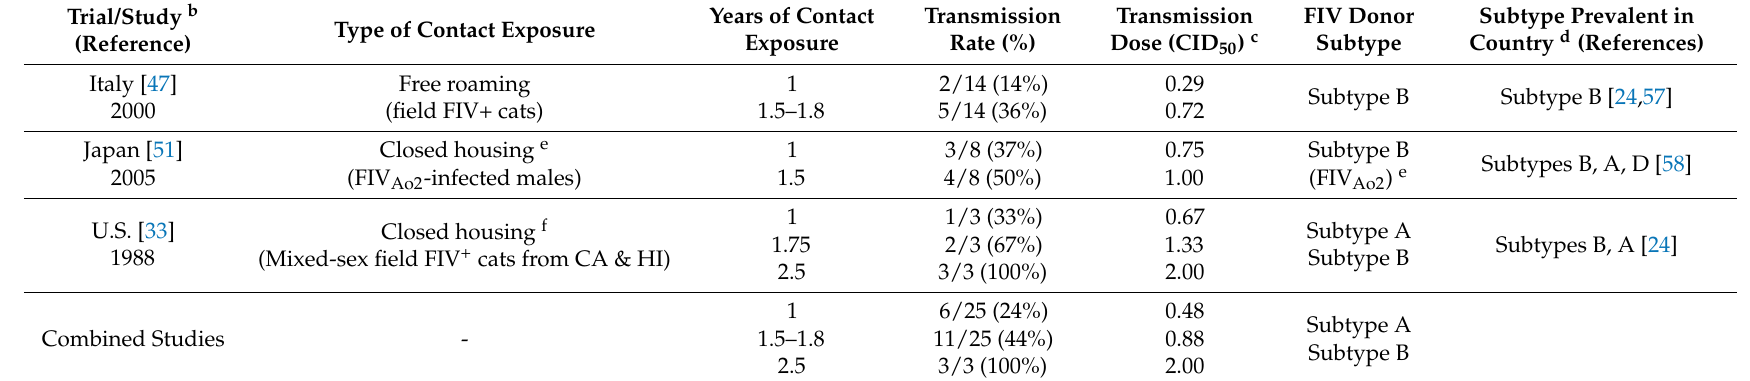
a Table adapted from reference [33]. b Contact exposure trials in three countries shown with either the publication date of the trial (Italy, Japan) or the start date of the study (U.S.)